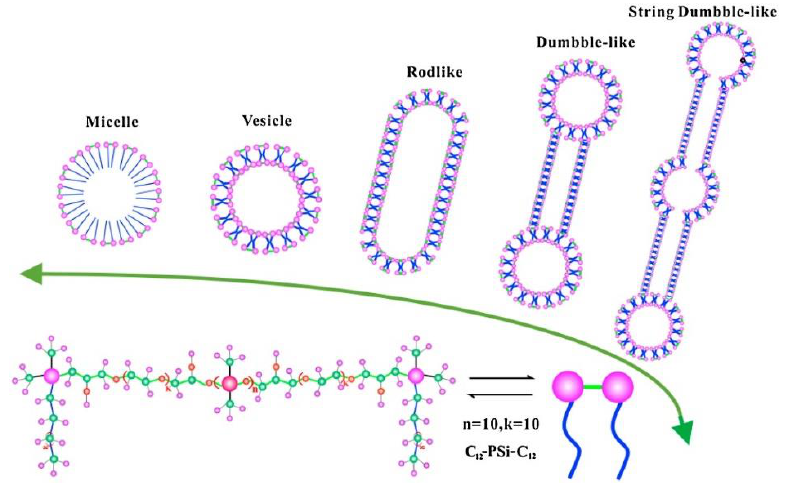
Figure 7. Possible models of morphological transition between aggregates of silicone-based surfactants at different concentration. Reprinted with permission from [123]. Copyright 2017 Elsevier.